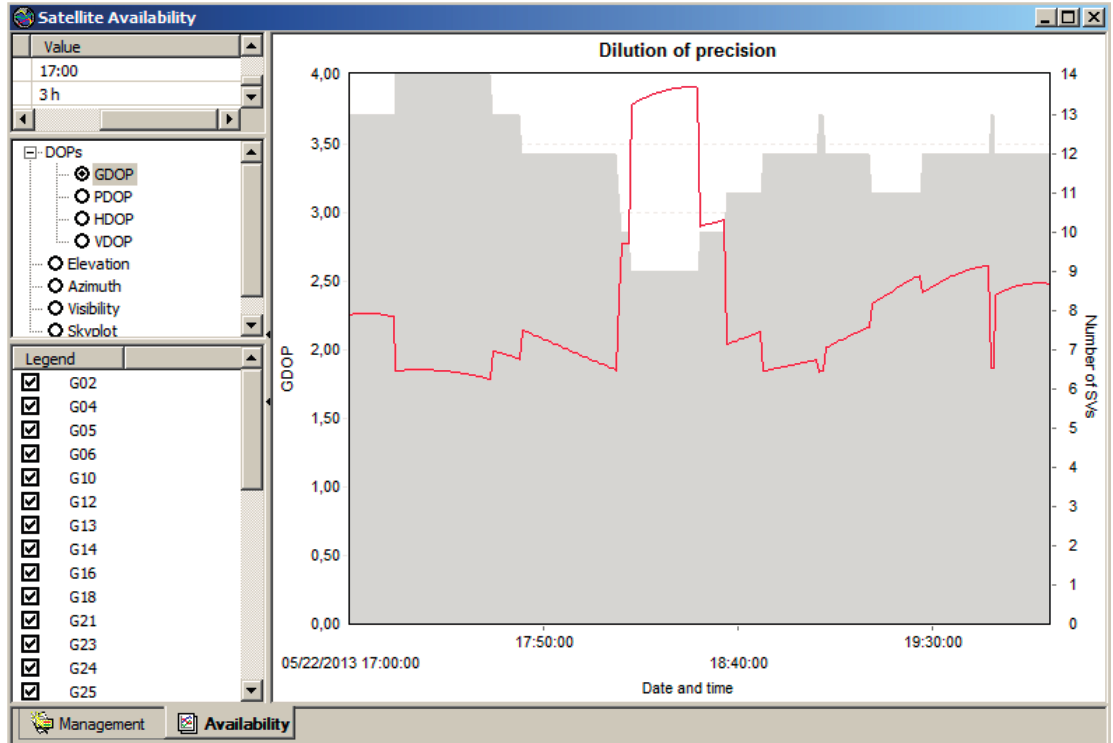
Figure 3. Number of visible satellites (SV) and geometric dilution of precision for the time of